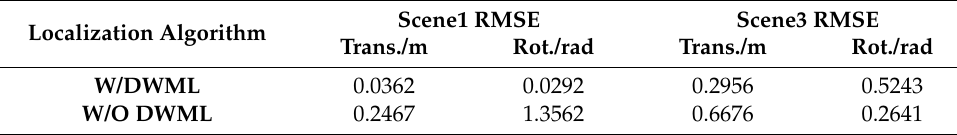
Table 2. Root mean square error value of Scene 1 and Scene